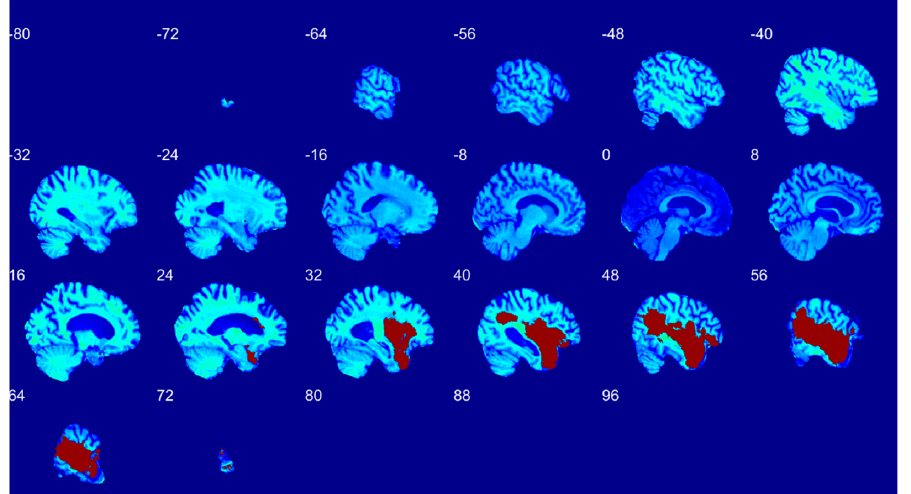
Figure 4. Coronal sections showing automatic segmentation of left MCA stroke as mapped on MNI152 template. The brain slices are sampled at the intervals of 8 mm.